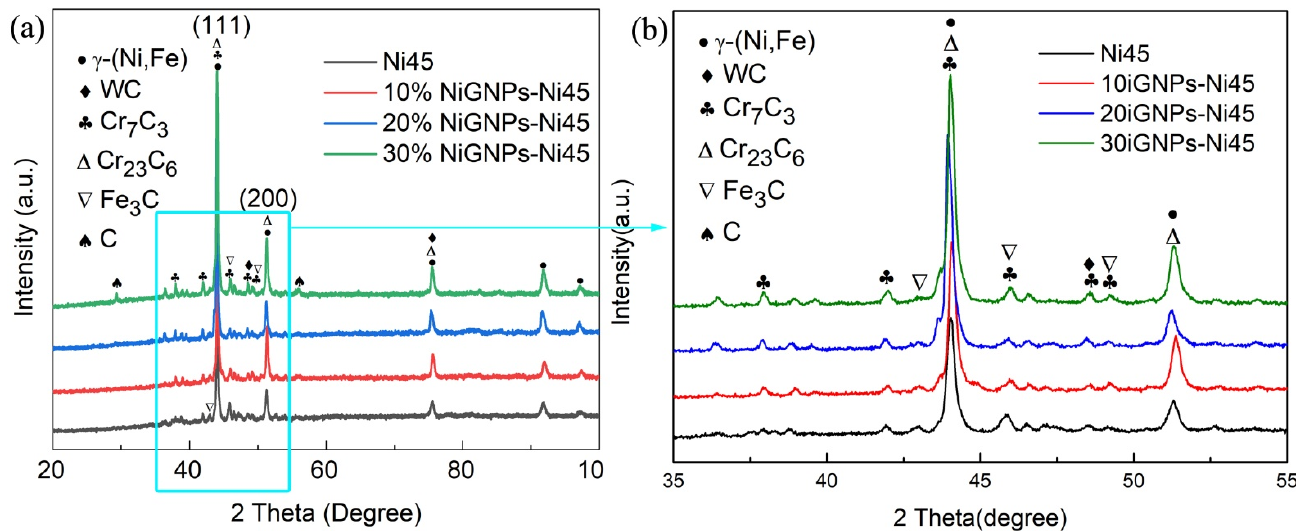
Figure 2. XRD patterns of different content of graphene nanosheets reinforced nickel-based composite coatings. ( a ) full patterns ( b ) Magnified patterns between 35° and 55°